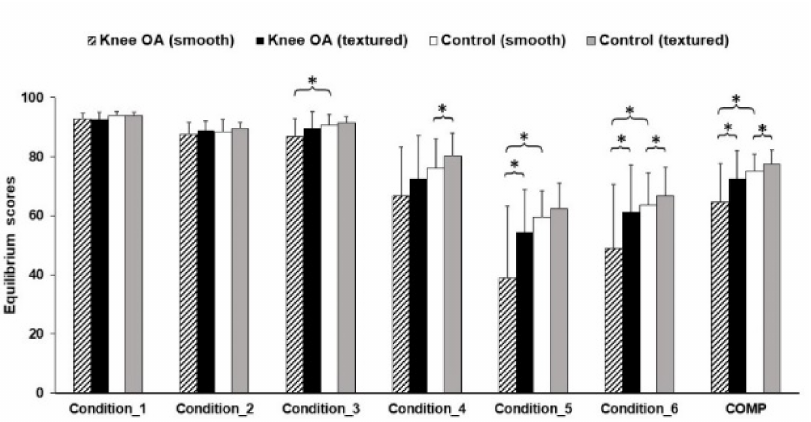
Figure 5. Equilibrium scores in the sensory organization test. * Statistically significant mean difference ( p < 0.05).